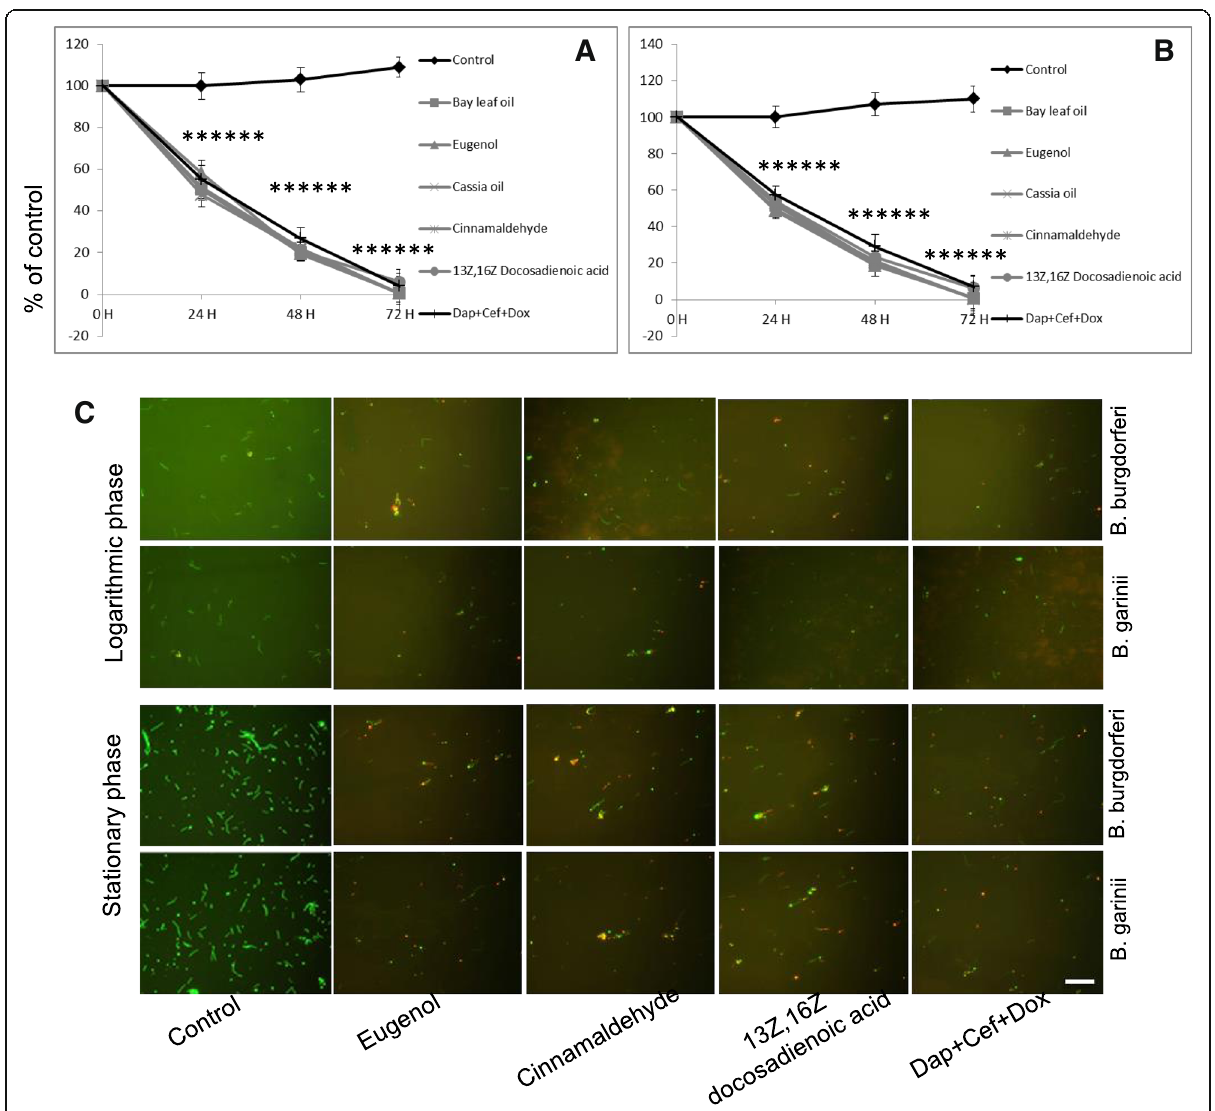
Fig. 1 Kinetic evaluation of anti-borreliae effects of selected lipids. Time-dependent killing efficacy of test lipids (oils at 0.15% including their active ingredients at 0.125% concentration, 13Z,16Z-docosadienoic acid at concentration 0.5mg/ml) against logarithmic and stationary phases of Borrelia burgdorferi s.s. ( a ) and Borrelia garinii ( b ) monitored up to 72h using direct counting and fluorescence microscope; * p ≤ 0.001 compared to control. Representative live (green)/dead (red) merged images of logarithmic phase and stationary phase of Borrelia burgdorferii s.s. and Borrelia garinii ( c ) after 24h incubation period with eugenol and cinnamaldehyde, as the active compounds of the most effective oils, 13Z,16Z-docosadienoic acid, and daptomycin+cefoperazone+doxycycline (Dap+Cef+Dox) as a positive control, taken at 200 x magnification, stained with BacLight dye; scale bar 50 μ